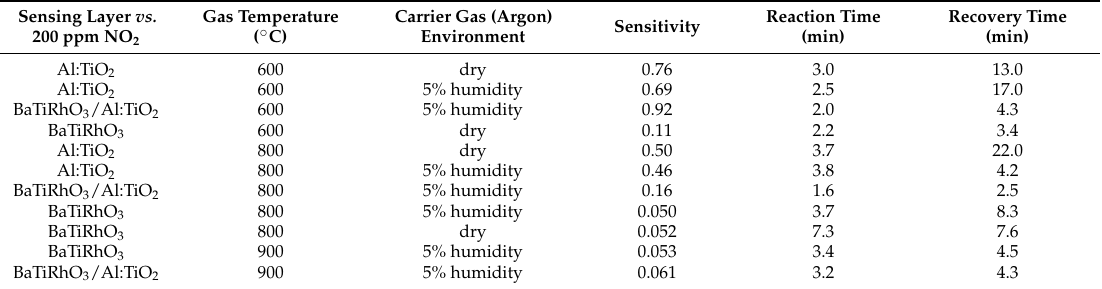
Table 1. Sensor properties of various sensor layers in the temperature range of 600–900 °C in dry or in 5% humid argon environment.